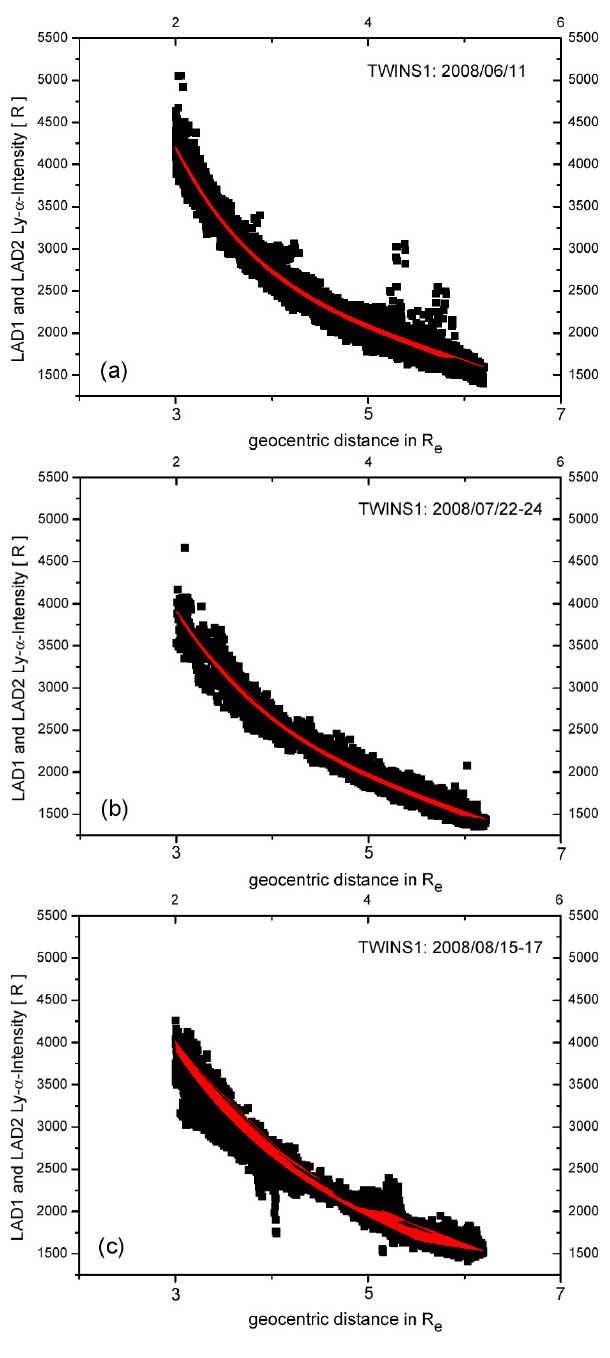
Fig. 3. Measured TWINS1 Ly- α -intensity profiles (black) in Rayleigh plotted versus the “line-of-sight” (LOS) earth passing geo- centric distance in R E for 11 June (a) , 22–24 July (b) and 15–17 August (c) in 2008. The red area is showing the calculated LOS- intensities based on the r -dependent H-density model which fits the general profile but could not explain the width of the intensity scat- ter within the profiles.